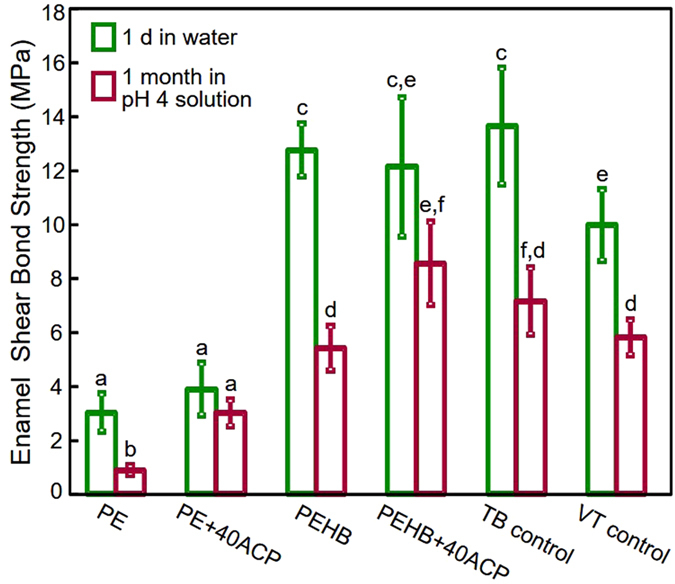
Orthodontic bracket shear bond strength (mean ± sd; n = 10).Green bars represent the specimens tested after 1 day in water. Red bars represent the specimens tested after immersion in demineralization solution of pH 4 for 1 month. Bars with dissimilar letters indicate values that are significantly different from each other (p < 0.05).